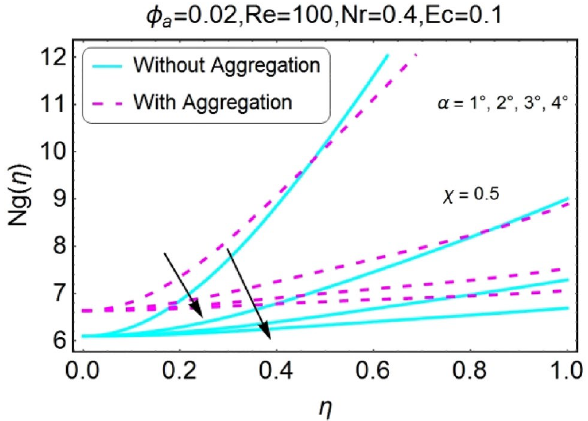
Figure 34. α varying entropy for stretching walls (divergent channel).